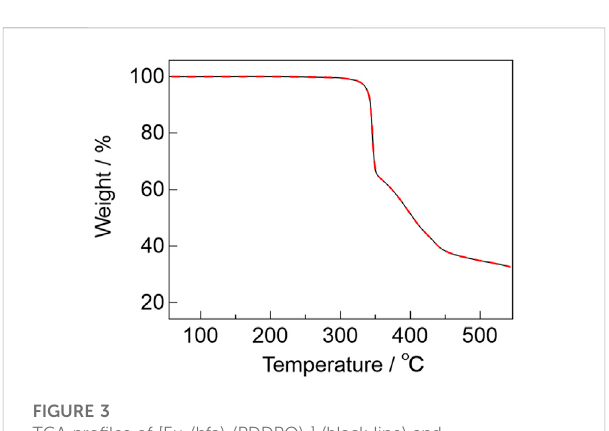
FIGURE 3 TGA pro fi les of [Eu 2 (hfa) 6 (PDDPO) 2 ] (black line) and